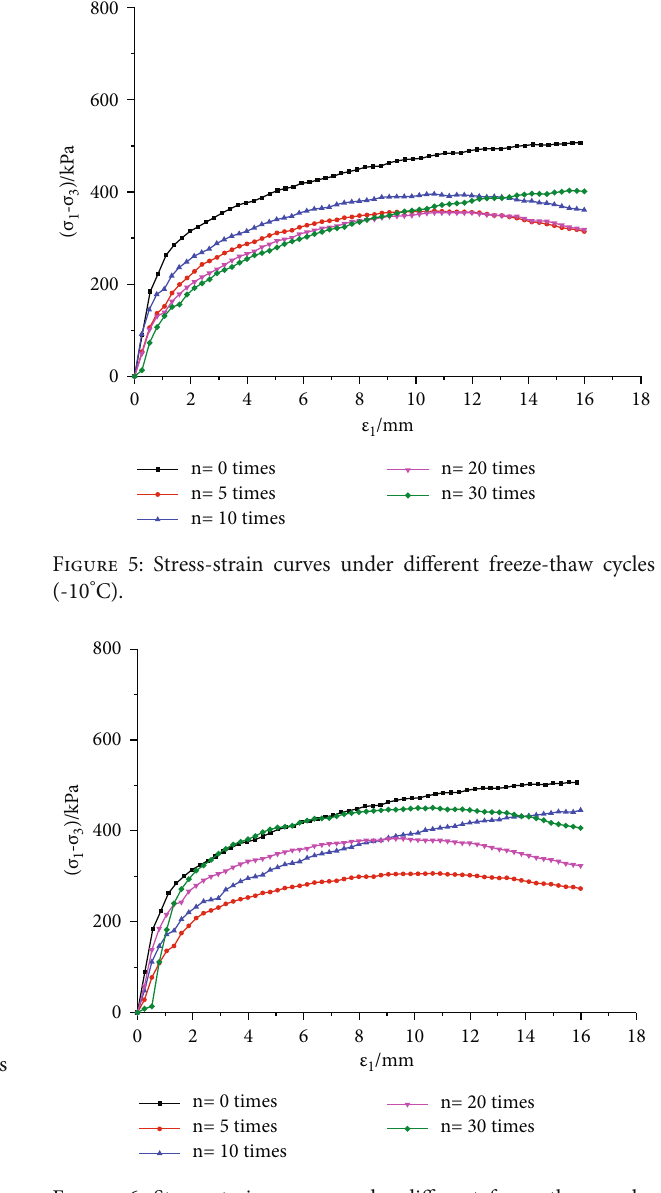
Figure 6: Stress-strain curves under di ff erent freeze-thaw cycles (-15 ° C).